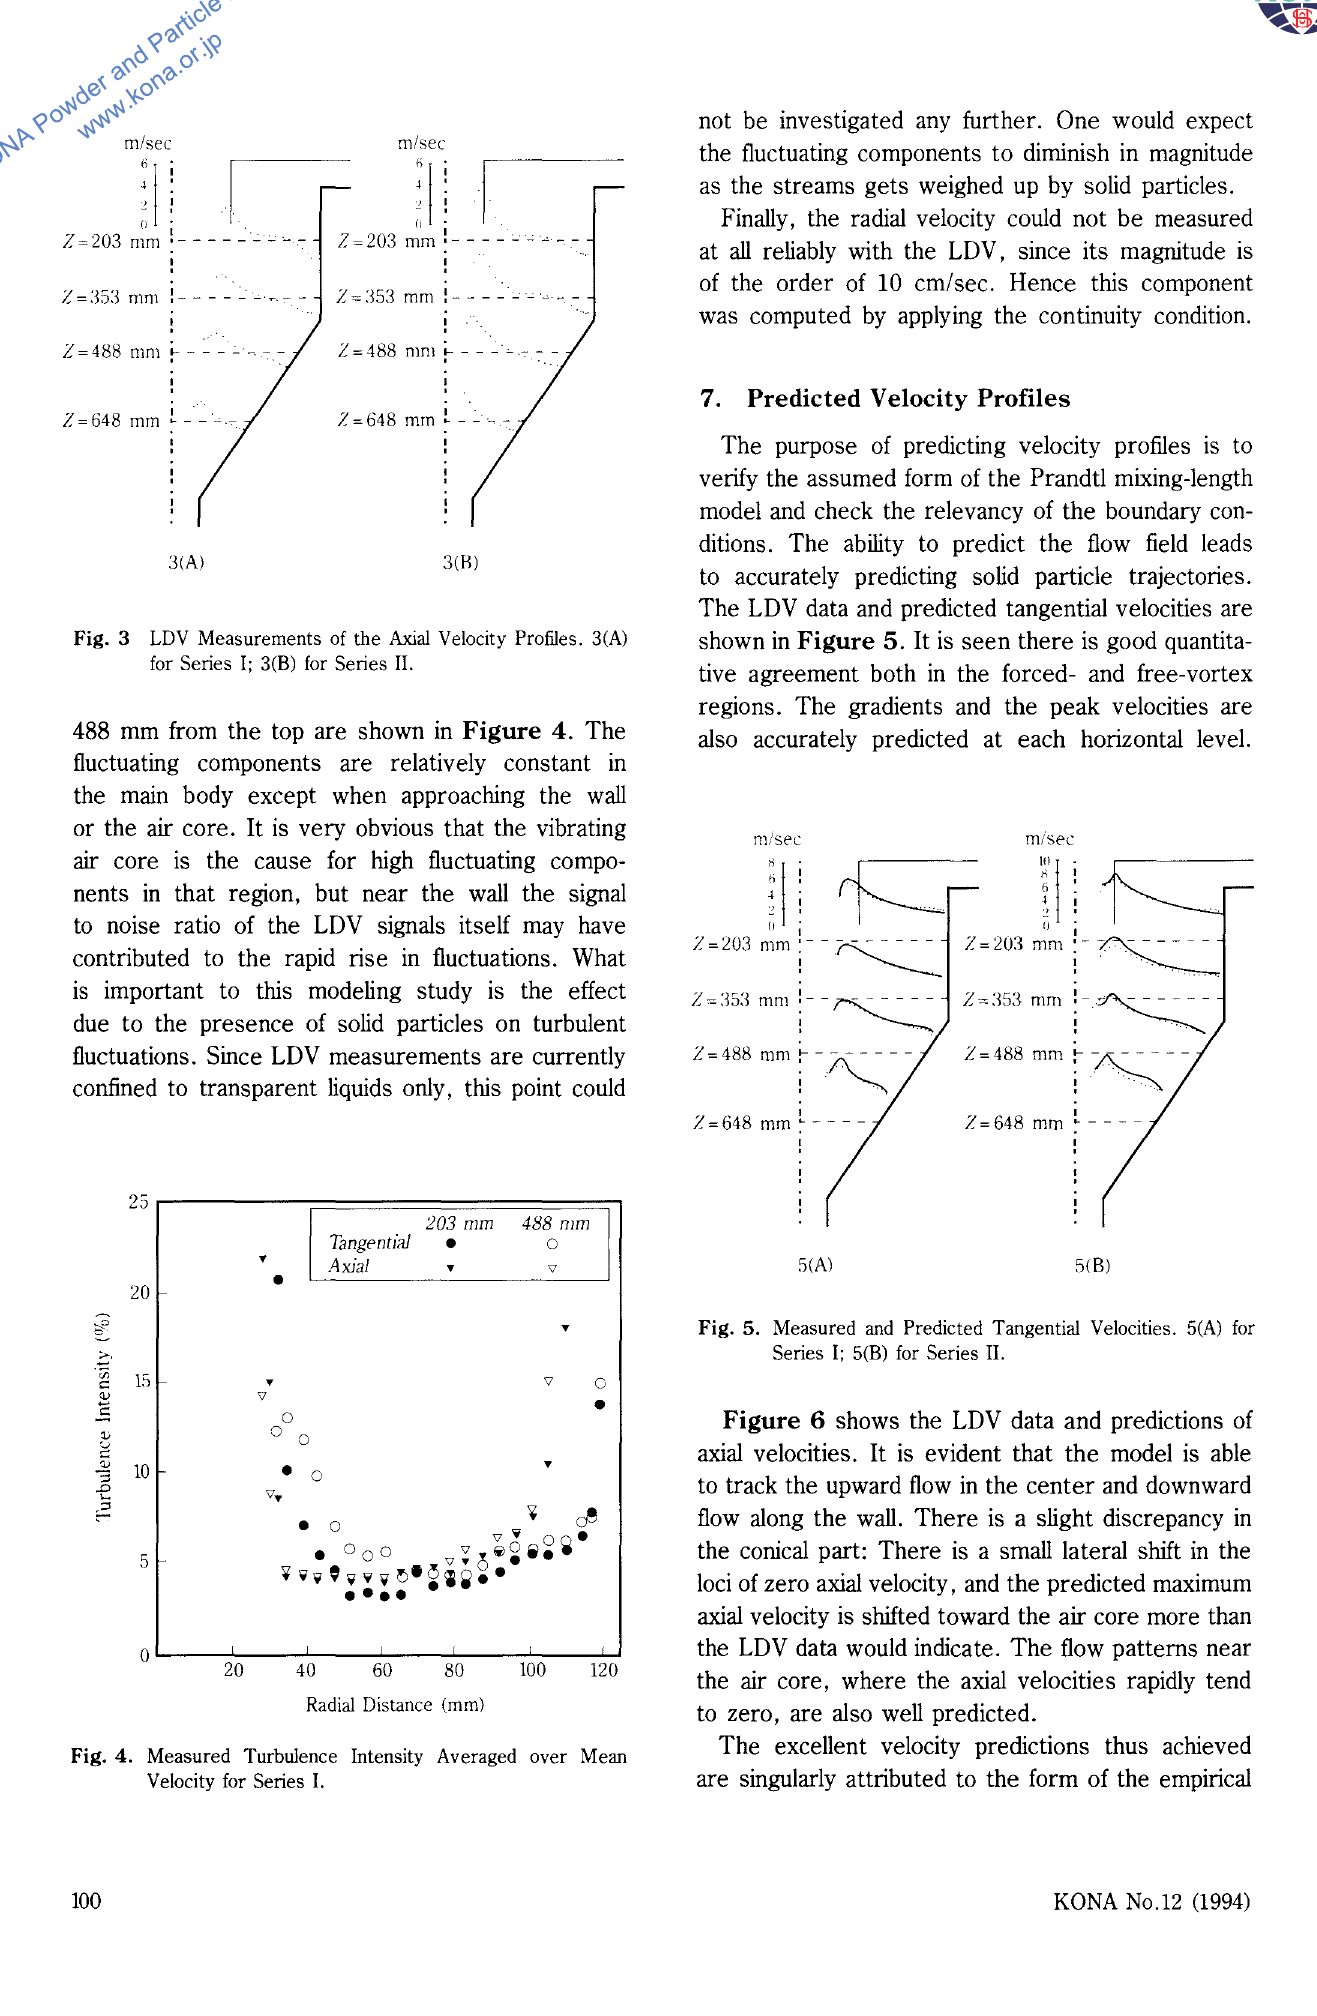
Fig. 4. Measured Turbulence Intensity Averaged over Mean Velocity for Series I.